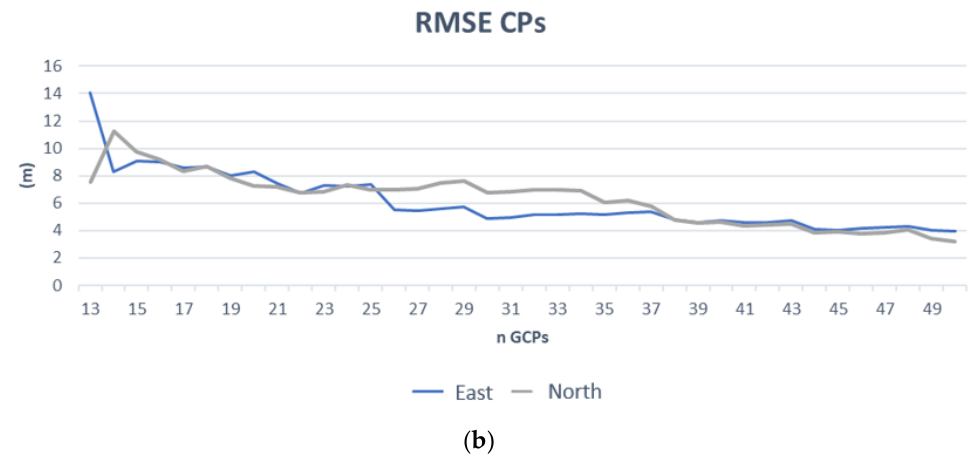
Figure 12. Trend of precision ( a ) and accuracy ( b ) in relation to the number of collimated GCPs, referred to the Rome test field.